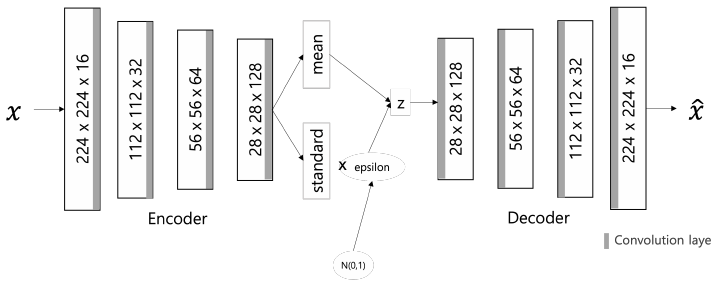
Figure 7. VAE model